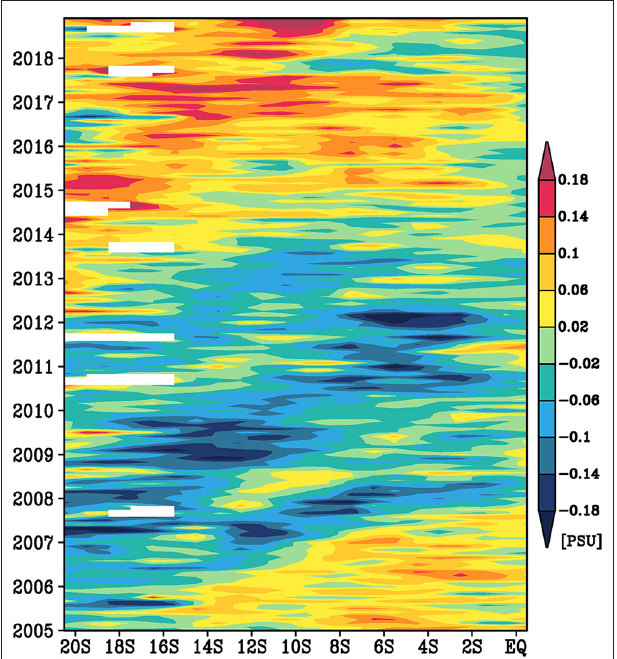
FIGURE 10 | A time-latitude diagram of the low-pass filtered salinity anomaly averaged vertically over the 25–25.5 σ θ isopycnals and zonally over the 6,000 and 6,500kg m − 1 s − 2 mean Montgomery potential